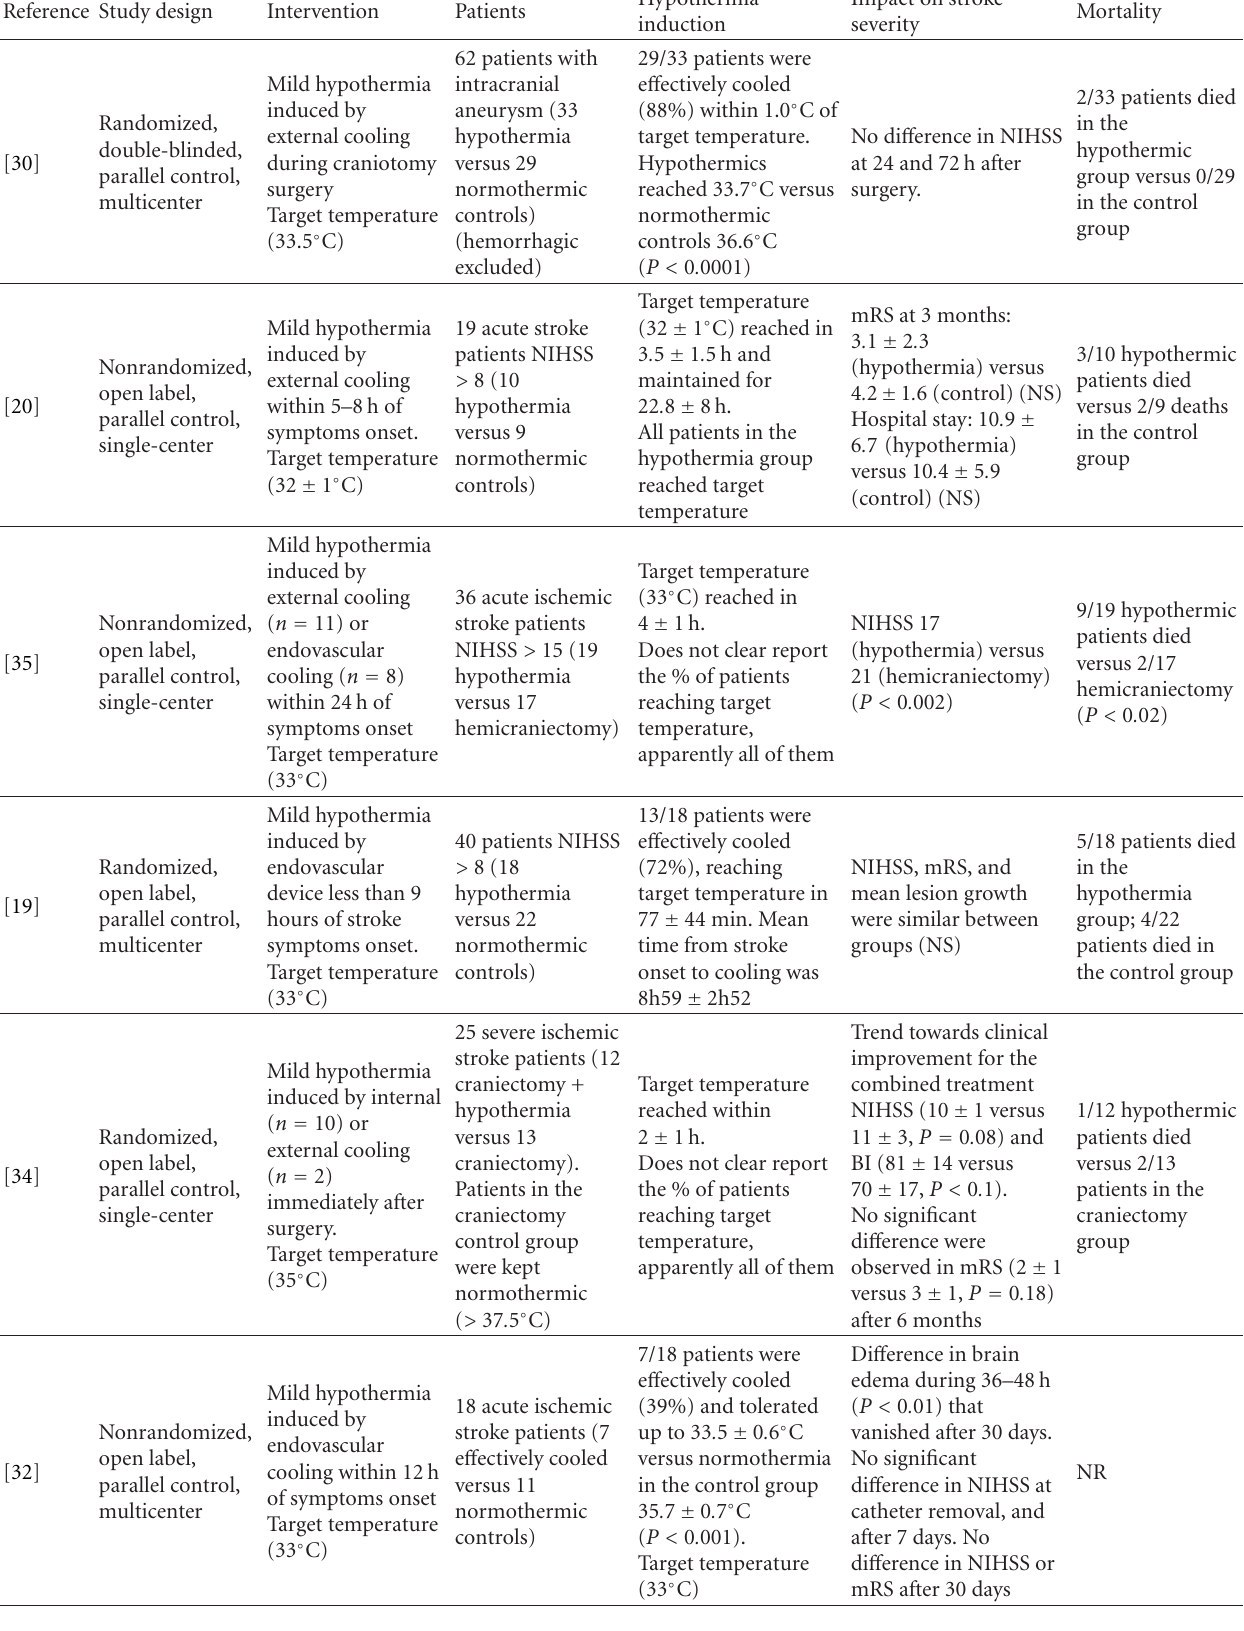
Table 3: Parallel-controlled clinical trials of feasibility and e ffi cacy of hypothermic intervention for stroke. Reference Study